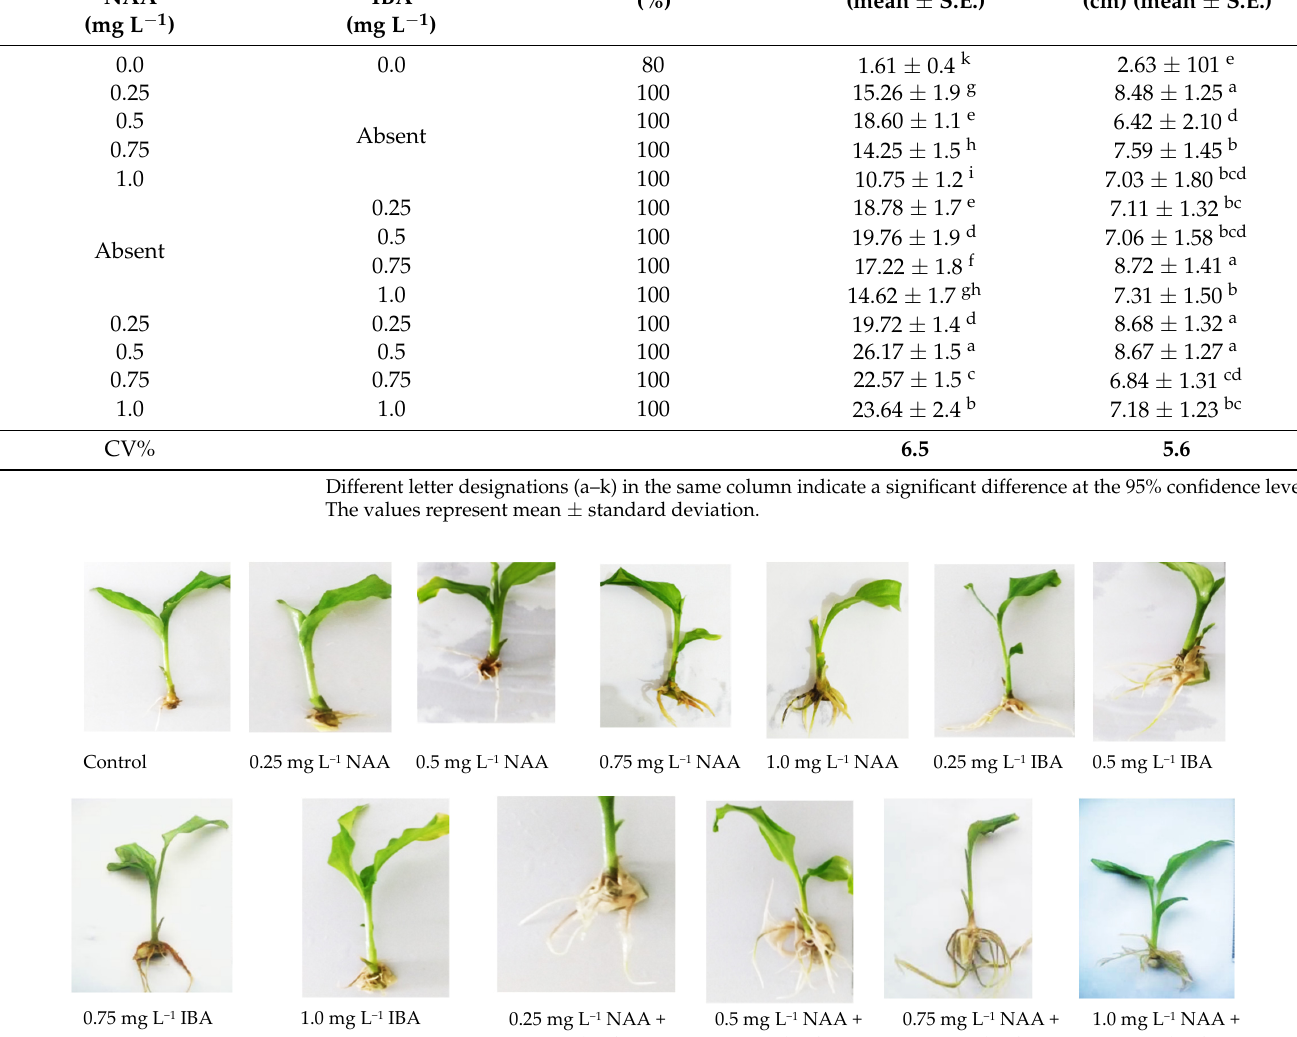
Table 3. Evaluation of IBA and NAA’s effect on rooting growth (after the second week of culture). Growth Regulators